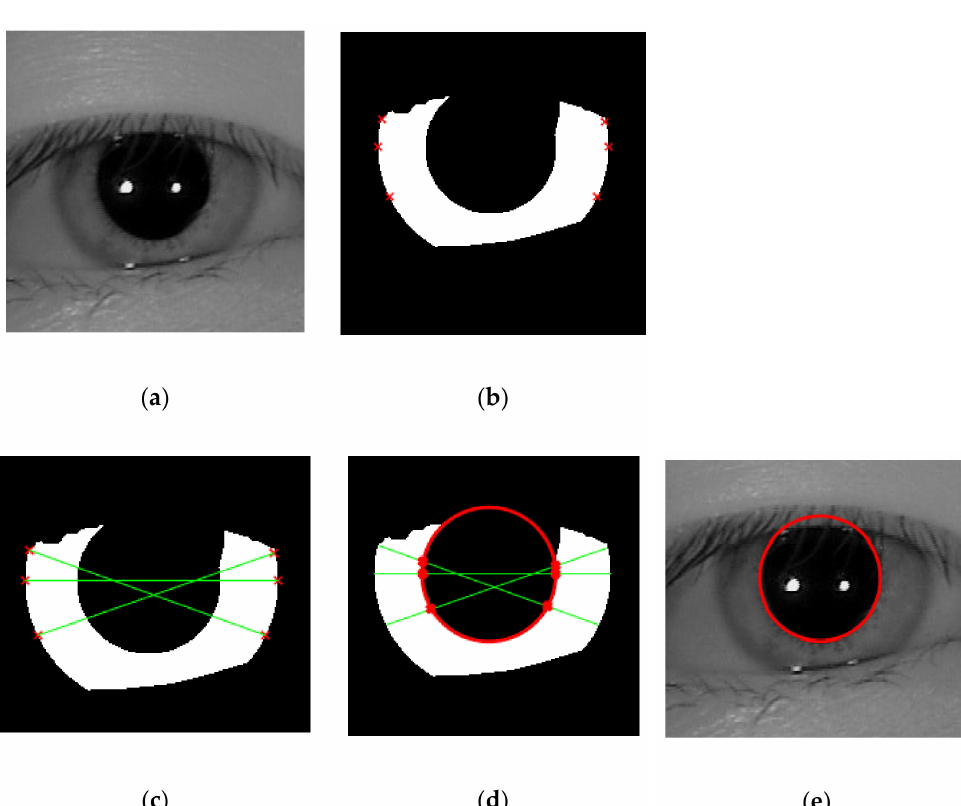
Figure 8. A pictorial example to show how to recover the inner boundary from the six saliency points derived from Figure 7. ( a ) The iris image whose upper part is occluded by eyelid; ( b ) the iris mask ROI and the six saliency points recovered by the proposed method; ( c ) a diagonal connection to connect each saliency points so that the line segments pass over the pupil region; ( d ) estimated pupillary boundary (shown in red color) recovered from the intersection of the line and inner part of the mask; ( e ) the pupillary boundary estimated by proposed method perfectly fits the pupil on iris